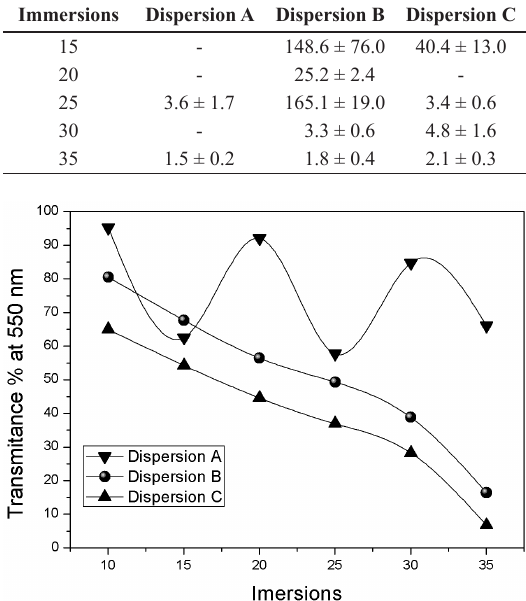
Table 1. Electrical resistance (KΩ) obtained by two terminals method. Immersions